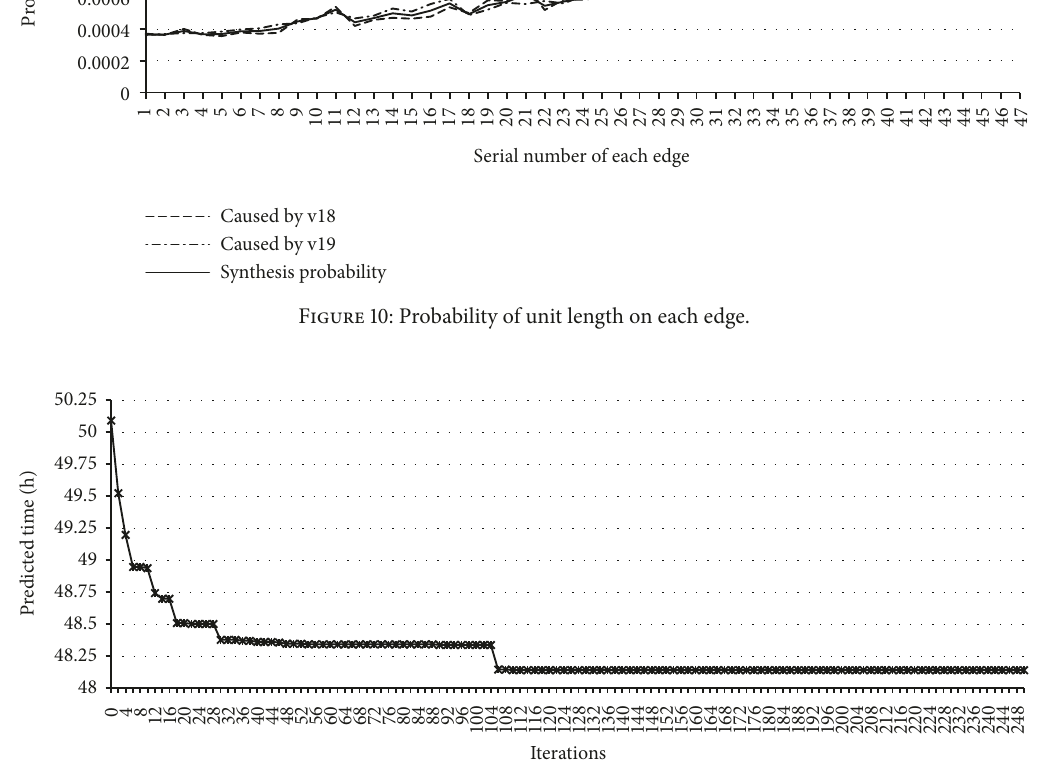
Figure 11: The convergence procedure based on predicted